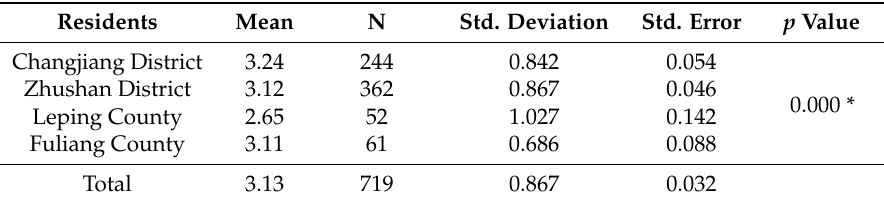
Table 4. The descriptive statistic of the flood risk perception of case areas. Residents Mean N Std. Deviation Std.